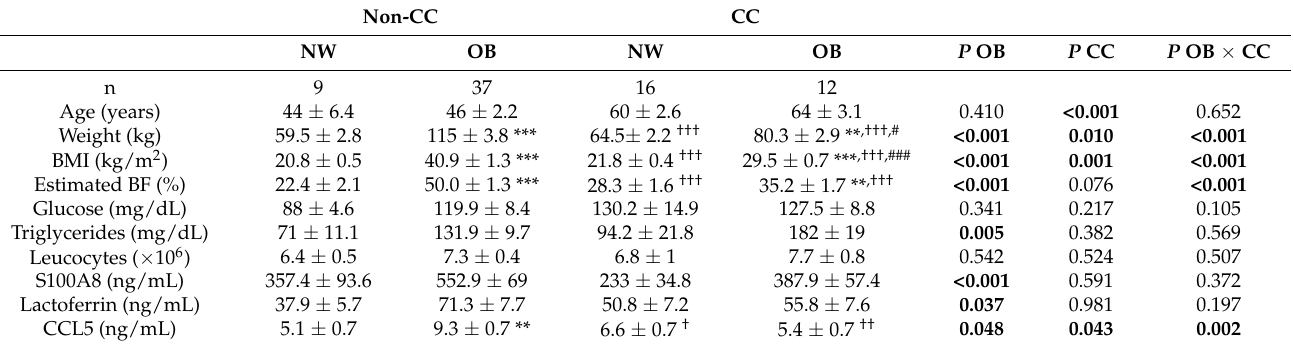
Table 1. Anthropometric and biochemical characteristics of the volunteers included in the